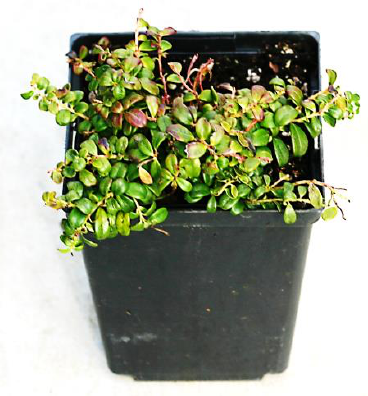
Figure 4. Greenhouse-grown lingonberry tissue culture plant.